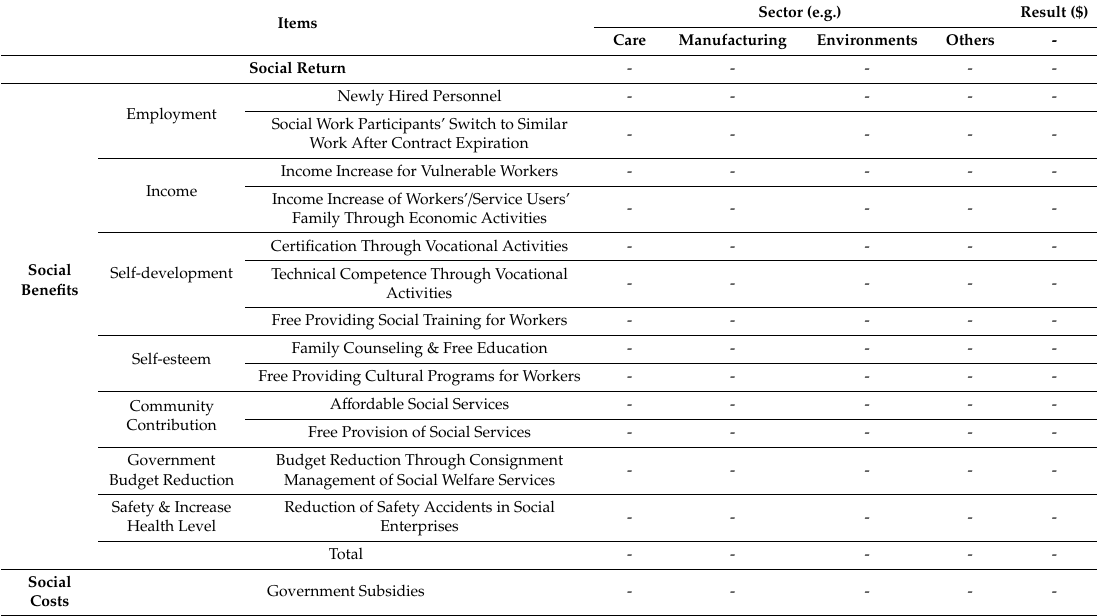
Table A2. Socio-economic Value Assessment by